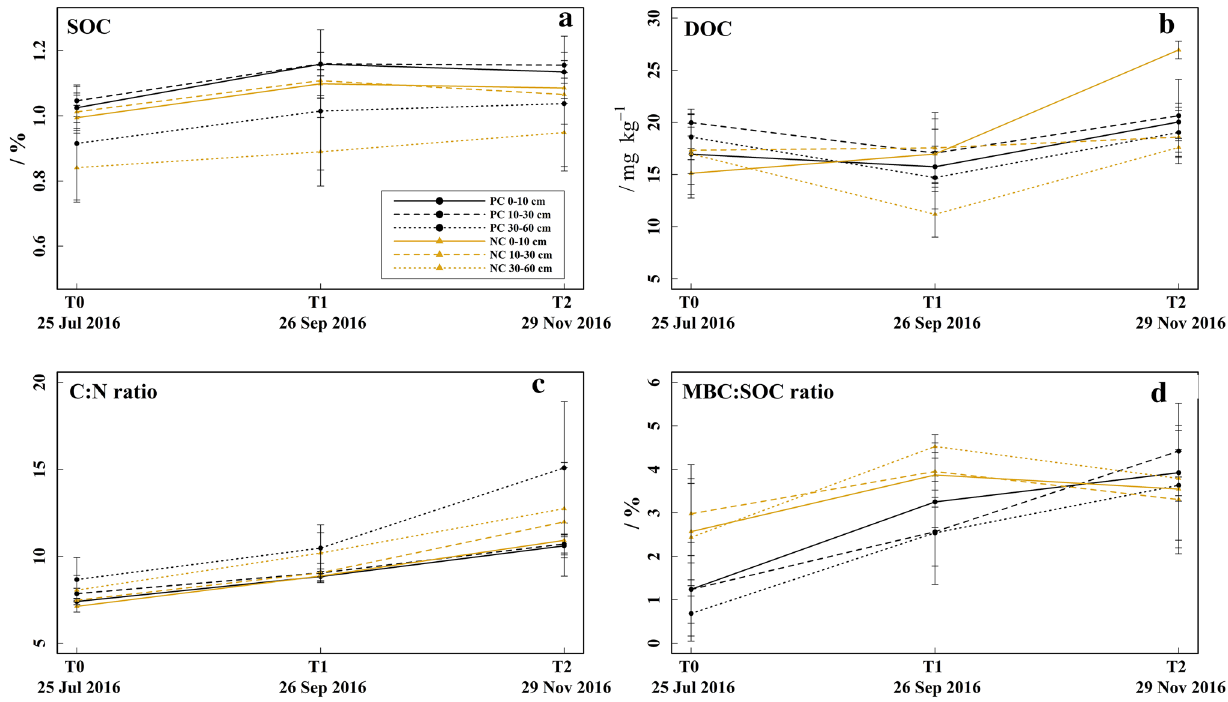
plastic coverage (PC) and no coverage (NC), respectively, shown as mean with standard deviation (n = 5). b Dissolved organic carbon (DOC), c C:N ratio, d MBC:SOC